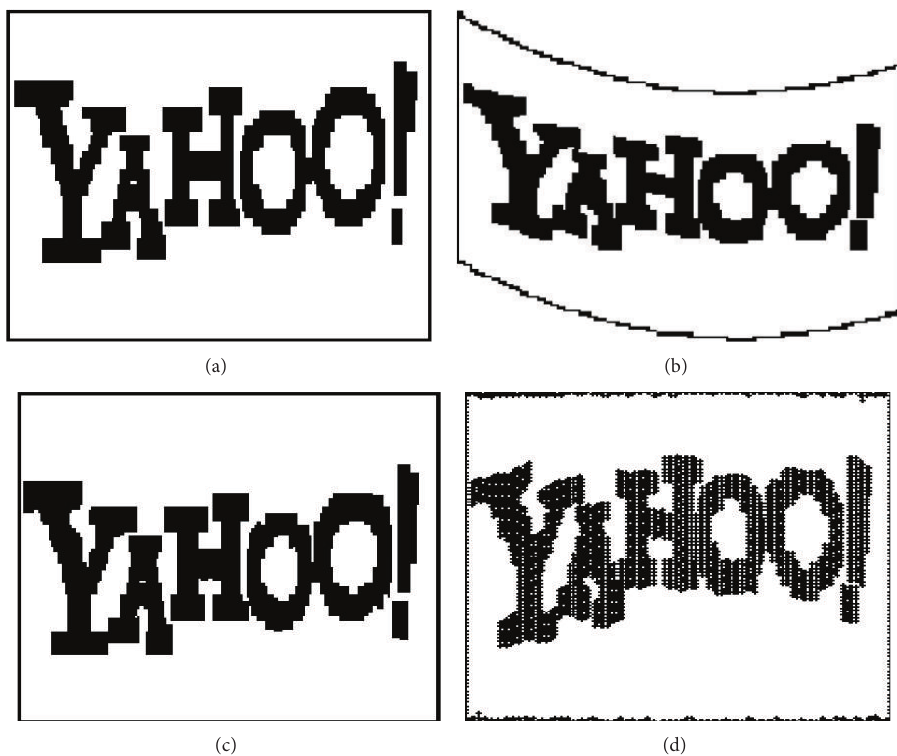
Figure 7: Experiment 1: nonlinear harmonic and its inverse: (a) original image, (b) distorted image, (c) restored image by IEWC, and (d) restored image by bilinear method.